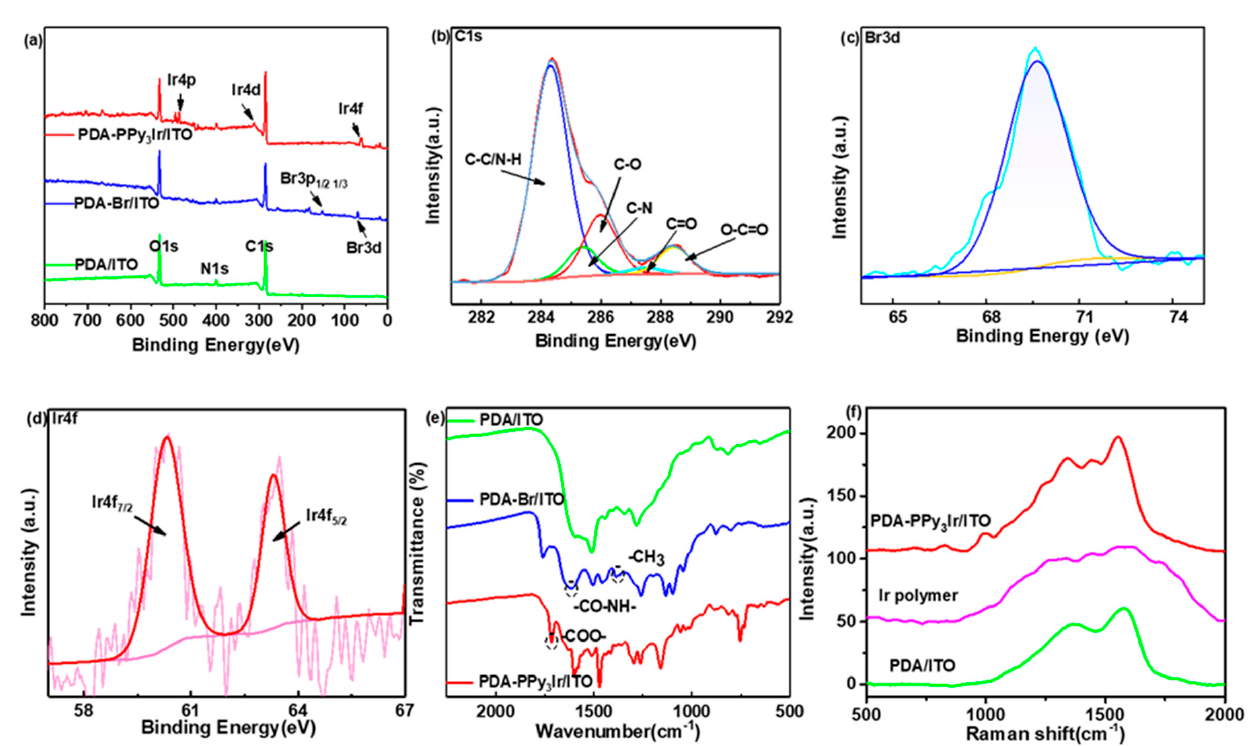
Figure 1. ( a ) XPS wide-scan spectra of different substrates; ( b ) C 1s core-level spectra of PDA/ITO; ( c ) Br 3d core-level spectra of PDA-Br/ITO; ( d ) Ir 4f core-level spectra of PDA-PPy 3 Ir/ITO; ( e ) FT-IR spectra of different substrates; ( f ) Raman spectra of substrates and the iridium